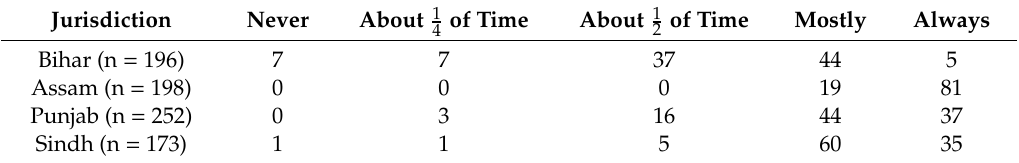
Table 4. Level of self-reported assessment of compliance with payment of fees (%), by jurisdiction.